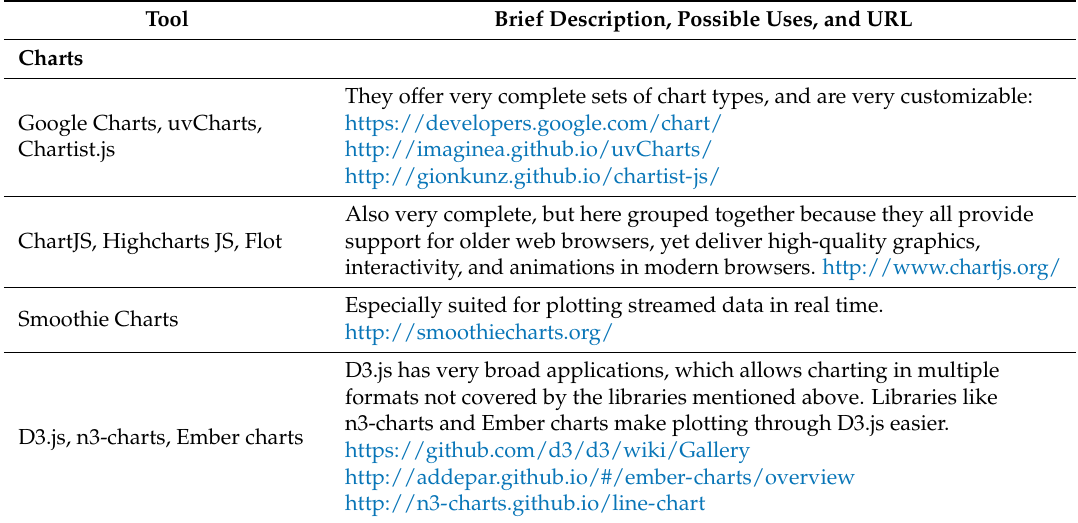
Table 3. Free JavaScript tools not directly intended for, but with potential utility in, molecular biosciences. The listing is by no means extensive, and mainly tries to convey the reader a feel of the kinds of available tools and the potential of the technologies. Tool Brief Description, Possible Uses, and URL Charts Google Charts, uvCharts, Chartist.js